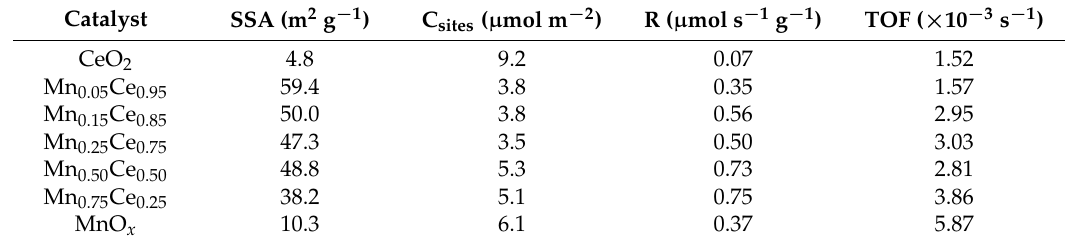
Table 3. Turnover Frequency (TOF) of ethanol oxidation at 180 ◦ C over Mn x Ce 1 − x catalysts.